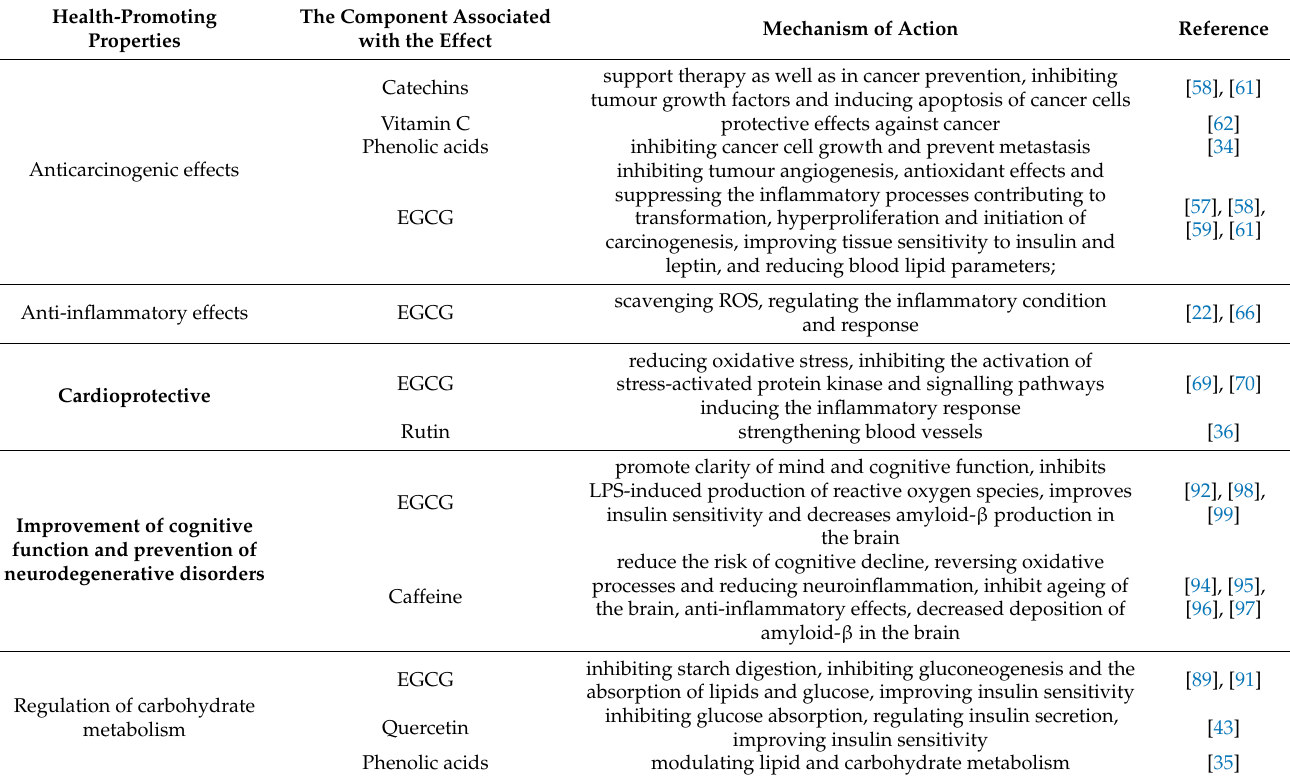
Table 2. Summary of research on the health-promoting properties of matcha green tea. Health-Promoting